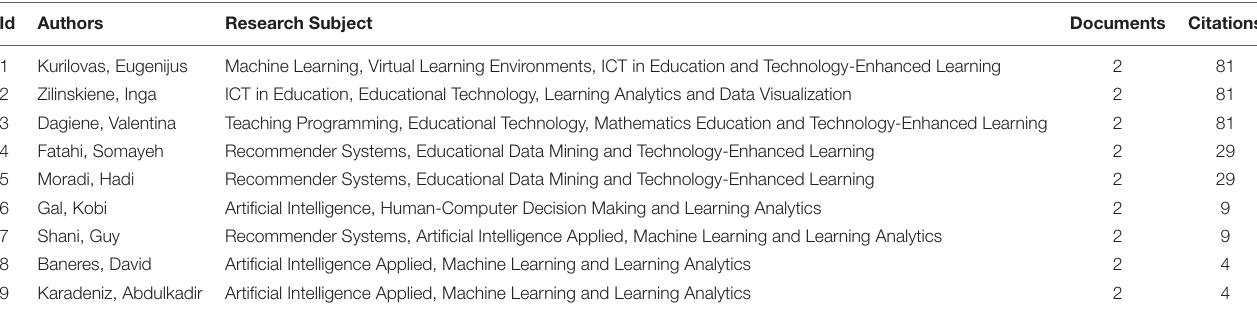
TABLE 3 | Author’s cooperation network from 2010 to 2021 (Documents ≥ 2).